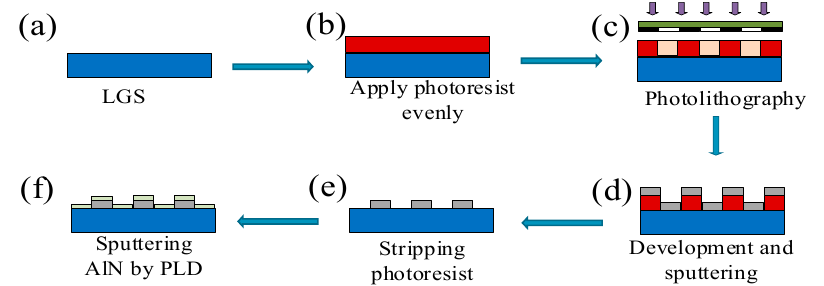
Figure 1. Schematic of the fabrication process of the sensor: ( a ) clean langasite (LGS) substrate; ( b ) apply photoresist evenly on the LGS surface; ( c ) lithography through reticle; ( d ) deposition of metal Pt/Cr by magnetron sputtering; ( e ) removal of photoresist; ( f ) AlN film deposition by PLD.